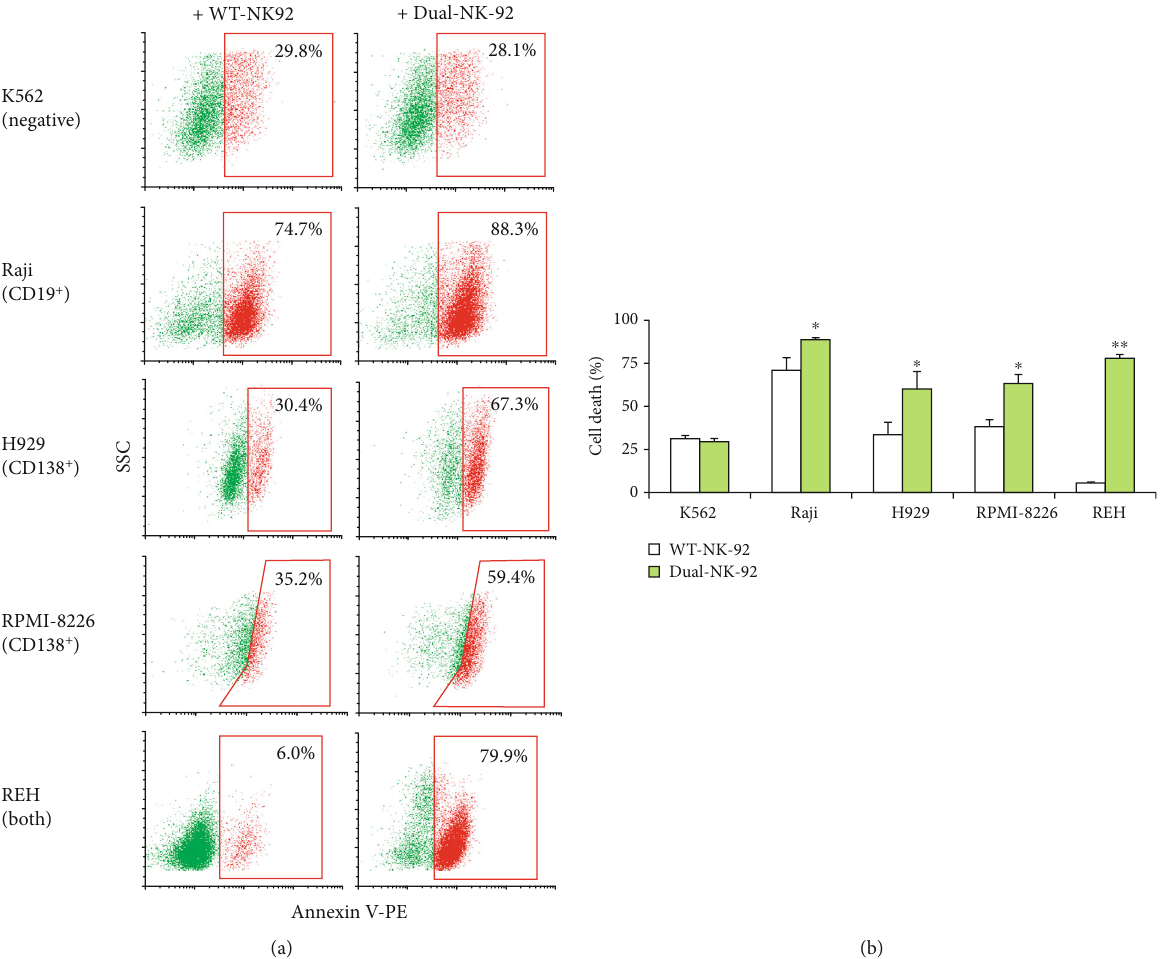
Figure 7: Selective cytotoxicity of dual CD19/CD138-NK-92 cells toward various hematologic cancer cells. (a) Human CML-derived K562, ALL-derived REH, BL-derived Raji, and MM-derived H929 and RPMI-8226 cells were labeled with PKH67 dye, incubated with WT-NK-92 or dual-NK-92 cells at the E : T ratio of 1:5 for 4h, and stained with Annexin V-PE. Representative fl ow cytometric dot plots of Annexin V-positive cells ( red box ) in PKH67-labeled cells were shown. (b) Percentage of cancer cell death was plotted. Data are mean ± s : d : ( n = 3 ). ∗ p < 0 : 05 and ∗∗ p < 0 : 01 versus WT-NK-92 cells; two-sided Student ’ s t